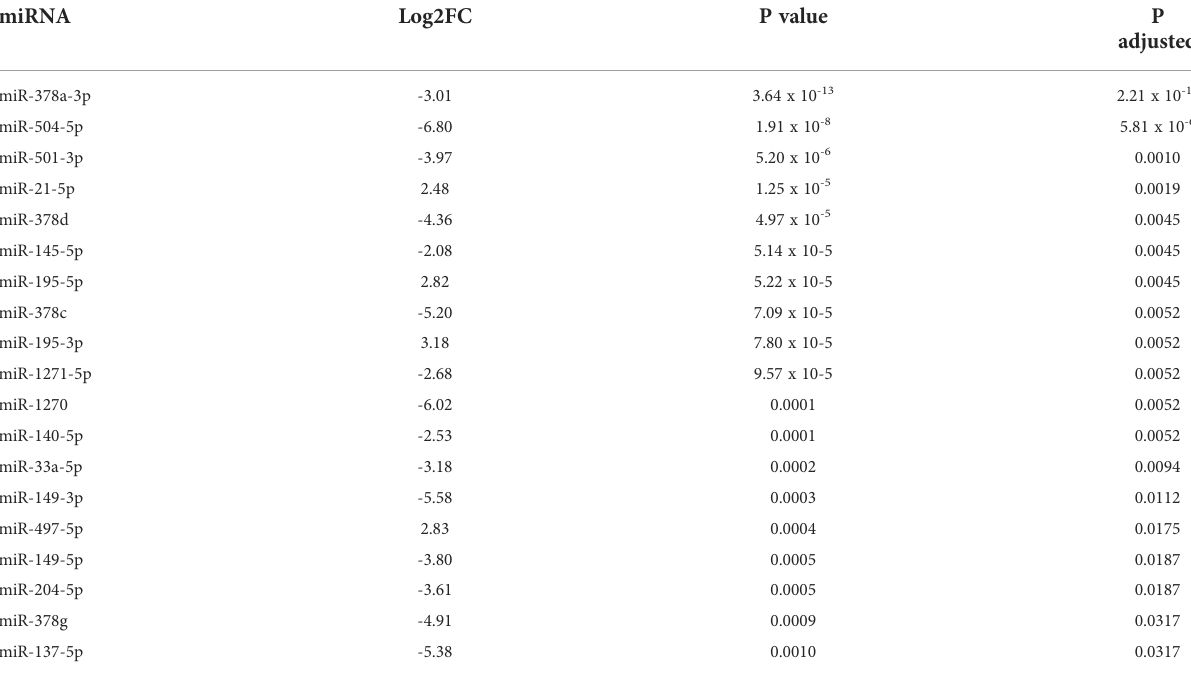
TABLE 3 Results of differential expression analysis between GH secreting PitNET tissues vs. NF PitNET